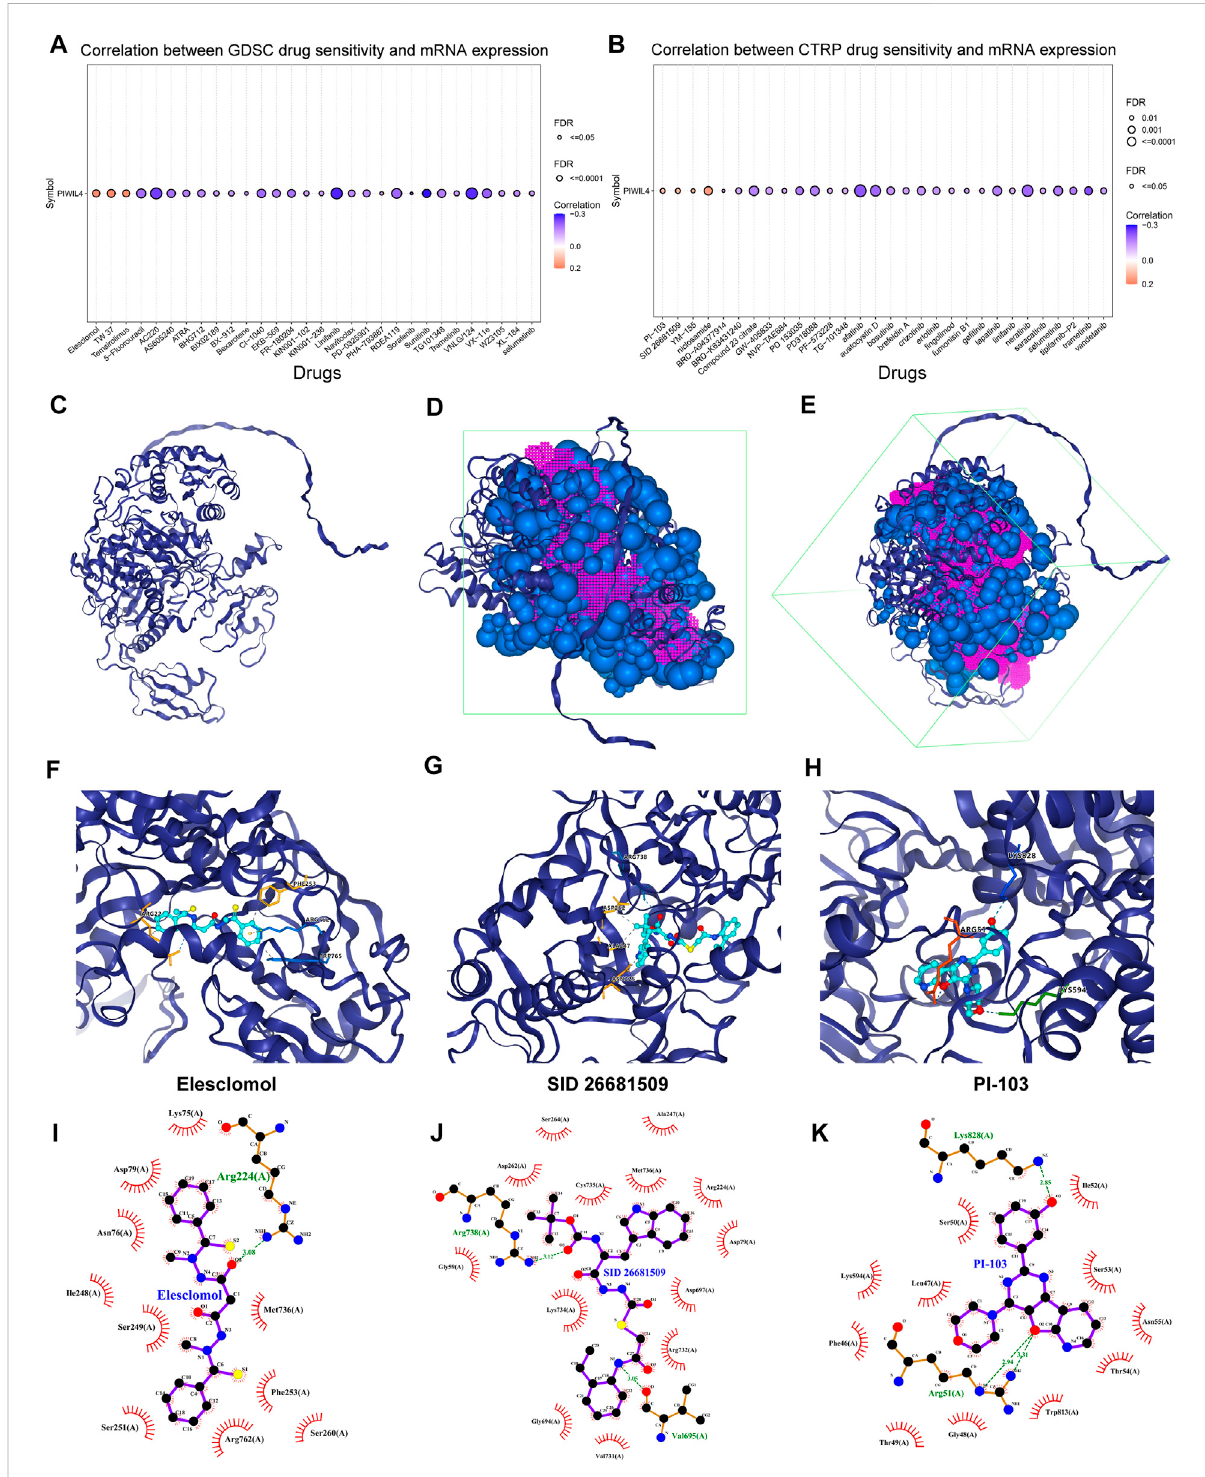
SusceptibledrugsestimationforPIWIL4protein. (A,B) PredictingtherelevancebetweenPIWIL4expressionanddifferentdrugsensitivitiesbased onGDSCandCTRPdatabases. (C) Thespatial structurediagramofthePIWIL4protein. (D,E) Potential bindingsitesandbox onPIWIL4protein. (F – H) The optimal docking space conformation of the drug to PIWIL4 protein. (Blue dotted line: Hydrogen bond; grey dotted line: Hydrophobic interaction; yellow dotted line: Cation interaction). (I – K) The interaction force between PIWIL4 protein and drugs was calculated by ligplus